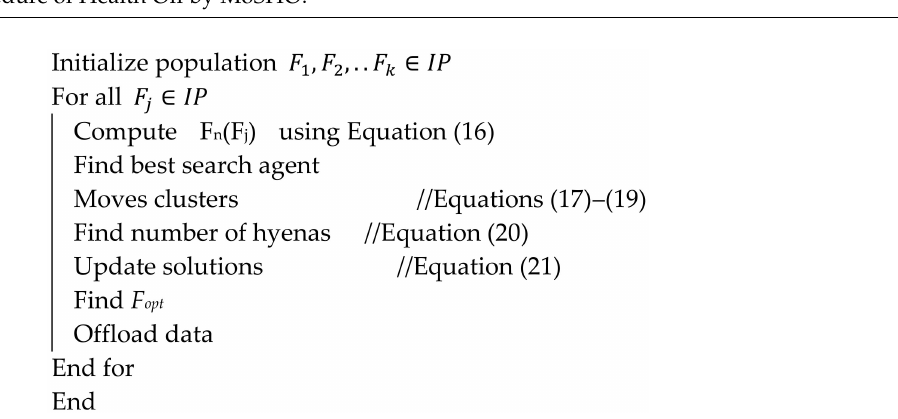
Algorithm 3: Procedure of Health Off by MoSHO.